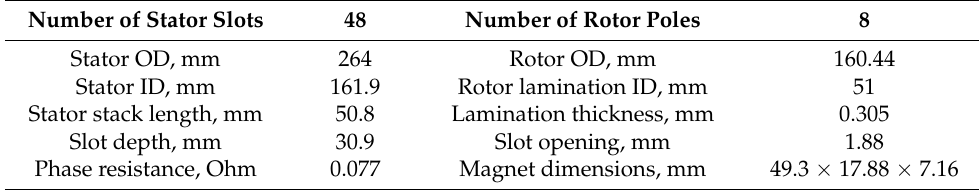
Table 1. Design specifications of Toyota Prius 2010 IPM machine.